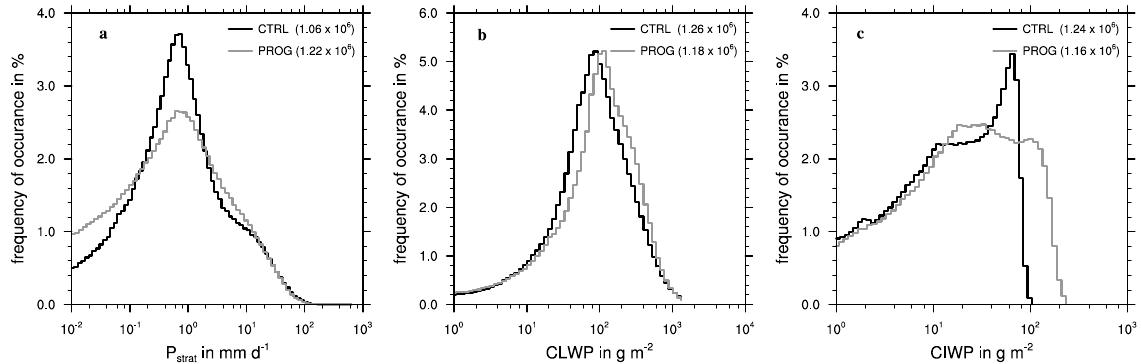
Figure 12. Frequency of occurrence of instantaneous (a) large-scale surface precipitation rate, (b) liquid water path and (c) ice water path for the month of July 2000 for both CTRL (black line) and PROG (gray line) simulations. Note that the x axes are in logarithmic scale and the numbers in the brackets correspond to the total number of events plotted.